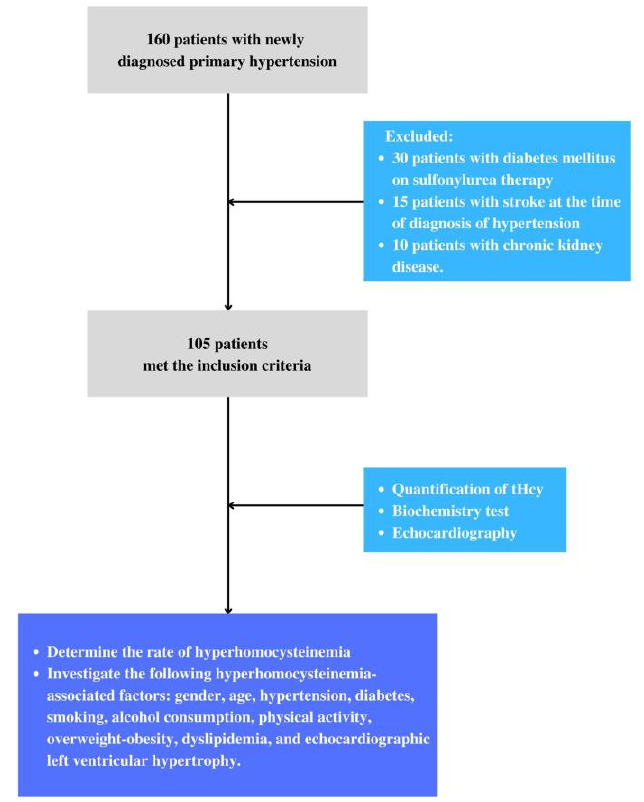
Figure 1. Participant flow diagram.